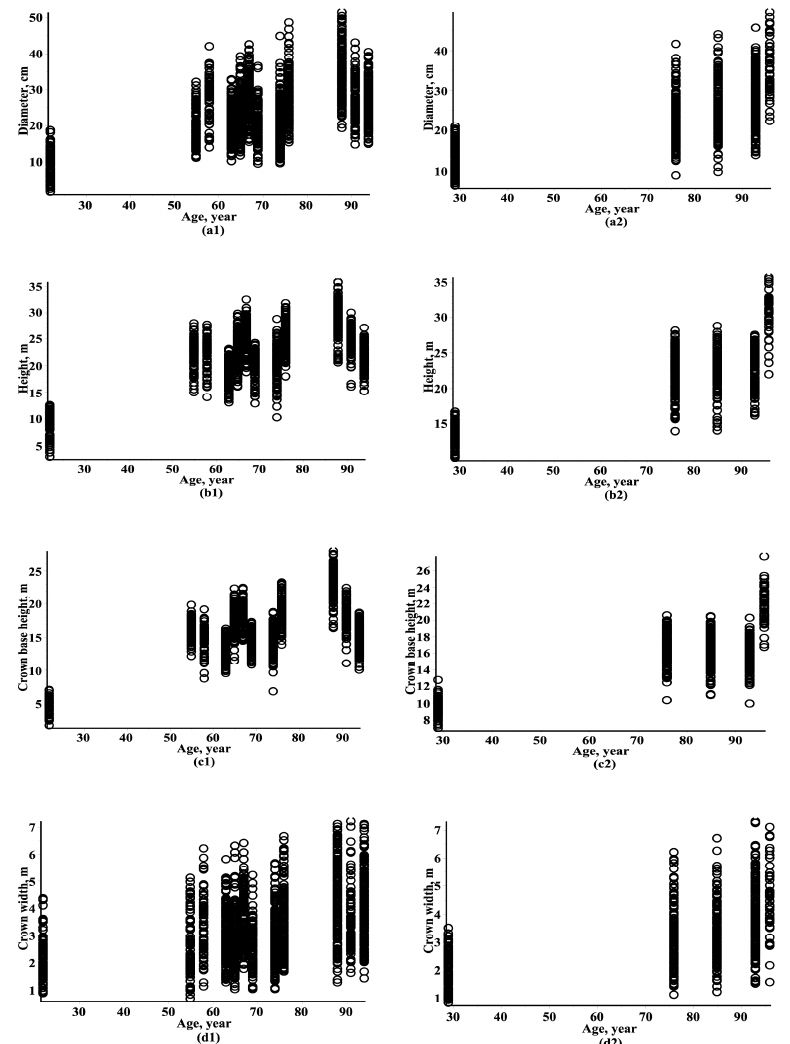
Figure 1. Observed datasets: ( a1 ) Estimation dataset of diameters; ( a2 ) Validation dataset of diameters; ( b1 ) Estimation dataset of heights; ( b2 ) Validation dataset of heights; ( c1 ) Estimation dataset of crown base heights; ( c2 ) Validation dataset of crown base heights; ( d1 ) Estimation dataset of crown widths; ( d2 ) Validation dataset of crown widths.